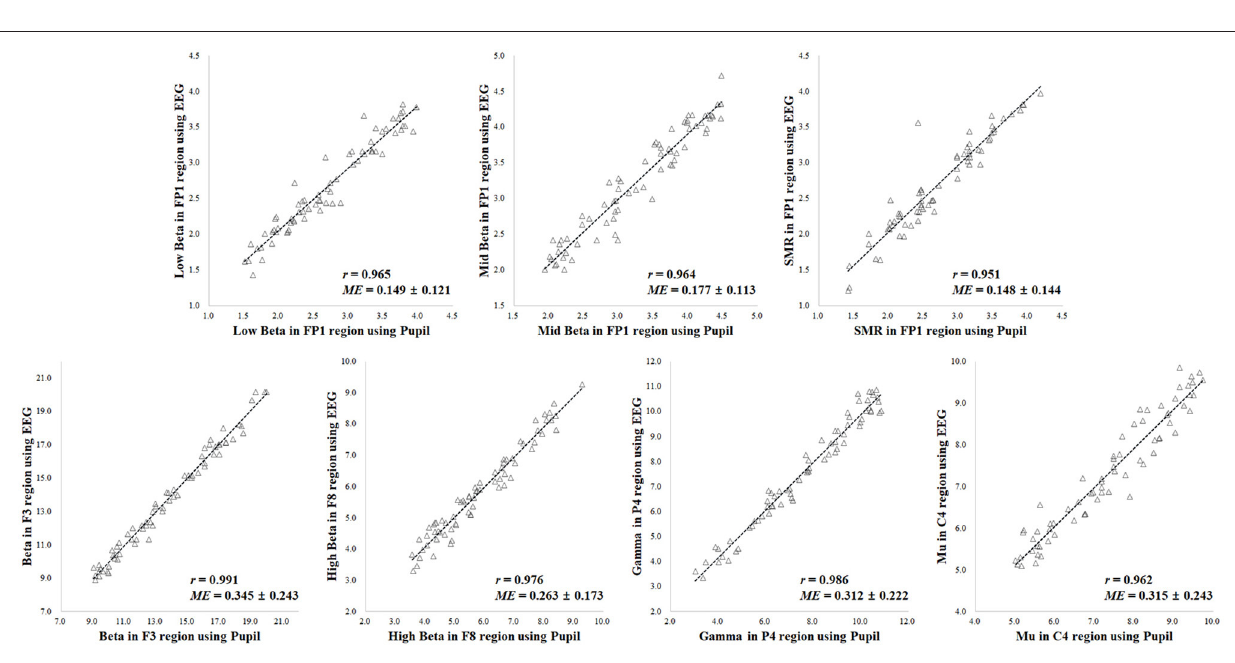
for executive monitoring from MVPC, ACC, and LPC (Lorist et al., 2000; Kennerley and Walton, 2011; Geva et al., 2013), and reflects the activation in LC-NE system by ACC top-down regulation (Botvinick,